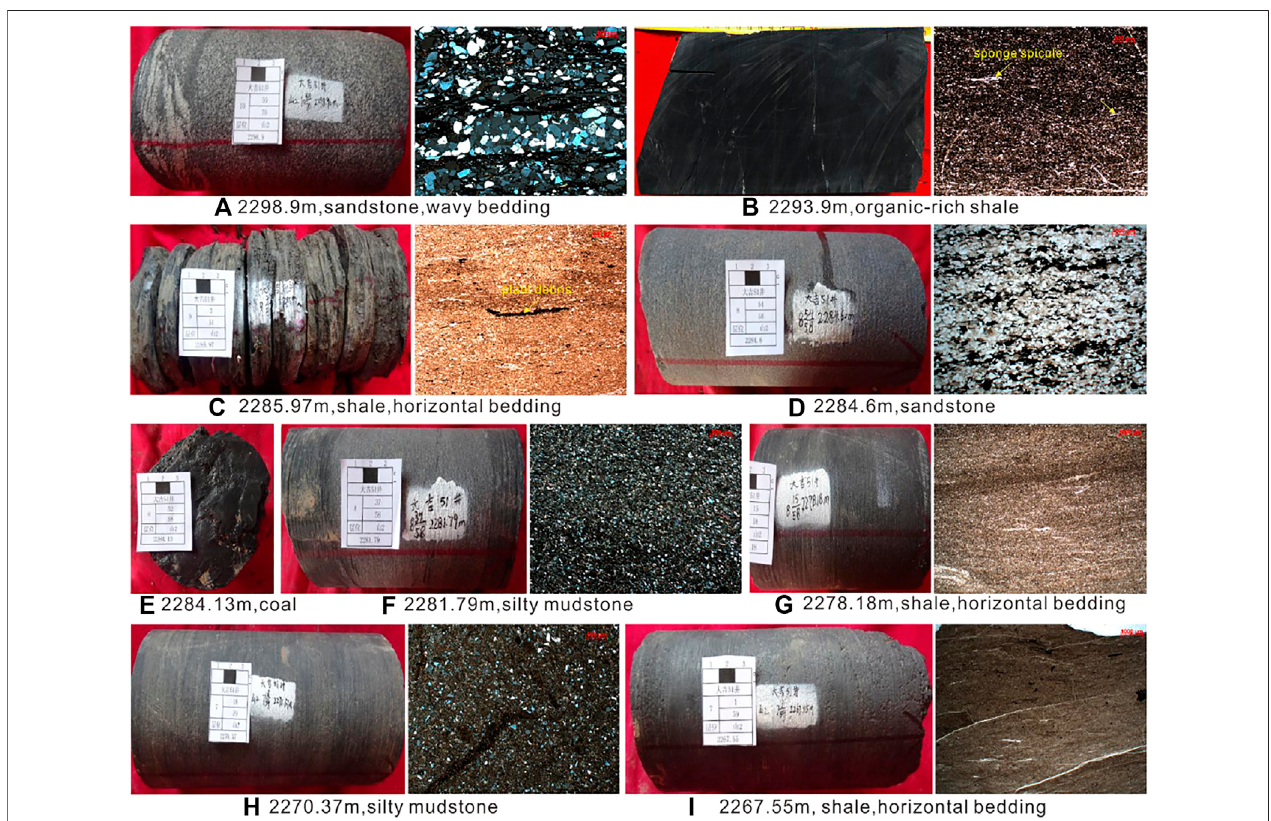
FIGURE2 | Macroscopic and microscopic petrological characteristics for Shanxi Formation Shan 2 3 Submember shale from the studied well in the Eastern Ordos Basin. (A) Greysandstonewithwavybeddingshowingargillaceousstrips,Shan2 3 -1section,2,298.9 m. (B) Blackorganic-richshalewithhorizontalbeddingcontaining sponge spicules under plane-polarized light, Shan 2 3 -1 section, 2,293.9 m. (C) Grey shale with horizontal bedding containing plant debris, Shan 2 3 -2 section, 2,285.97 m. (D) Sandstone with parallel bedding, Shan 2 3 -2 section, 2,284.6 m. (E) Coal, Shan 2 3 -3 section, 2,284.13 m. (F) Silty mudstone, Shan 2 3 -3 section, 2,281.79 m. (G) Greyshalewithhorizontalbedding,Shan2 3 -3section,2,278.18 m. (H) Siltymudstone,Shan2 3 -4section,2,270.37 m. (I) Dark-greyorganic-richshale with horizontal bedding, Shan 2 3 -4 section, 2,267.55